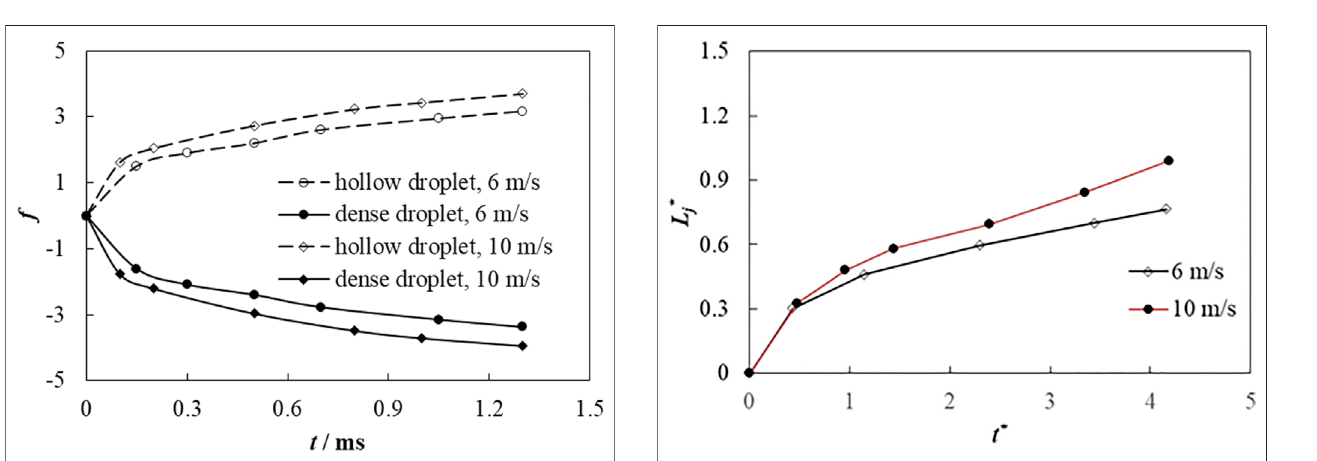
FIGURE 9 | Dimensionless counter jet height of hollow droplet at impact velocities of 6 and 10 m s − 1 .